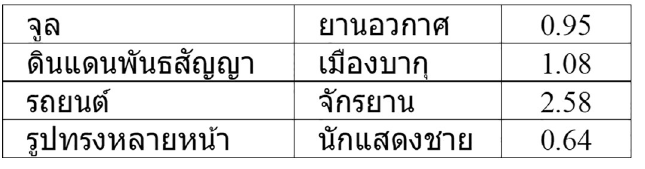
Fig 2. First four lines of